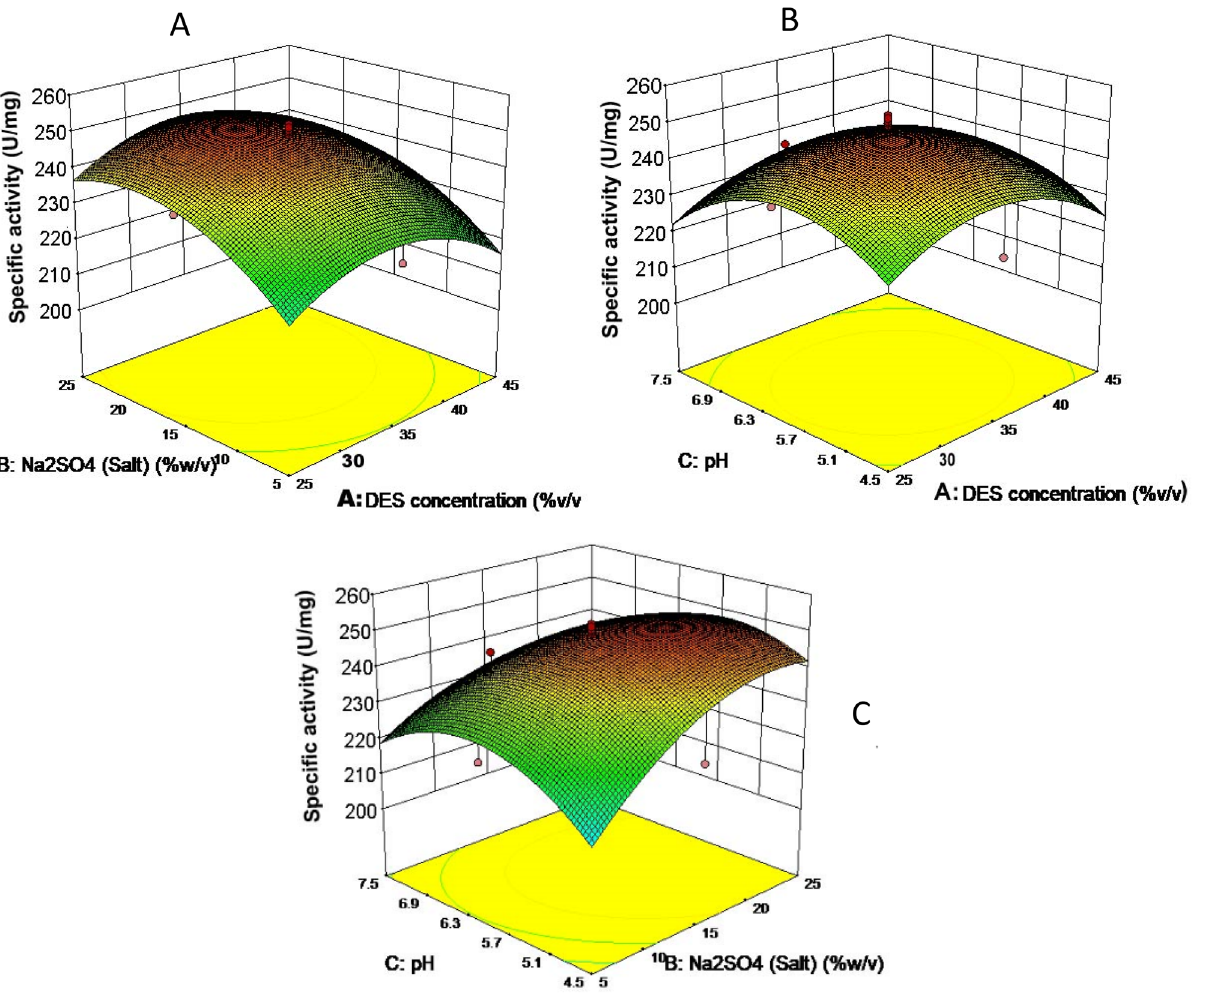
Figure 5. Response surface methodology based optimization of SDES concentration, Salt concentration and pH of medium for effective recovery of fibrinolytic protease. ( A ) Denotes the cumulative effect of DES and salt concentration, ( B ) denotes the cumulative effect of pH and SDES concentration and ( C ) denotes the effect contributed by pH in combination with salt concentration for selective recovery of the